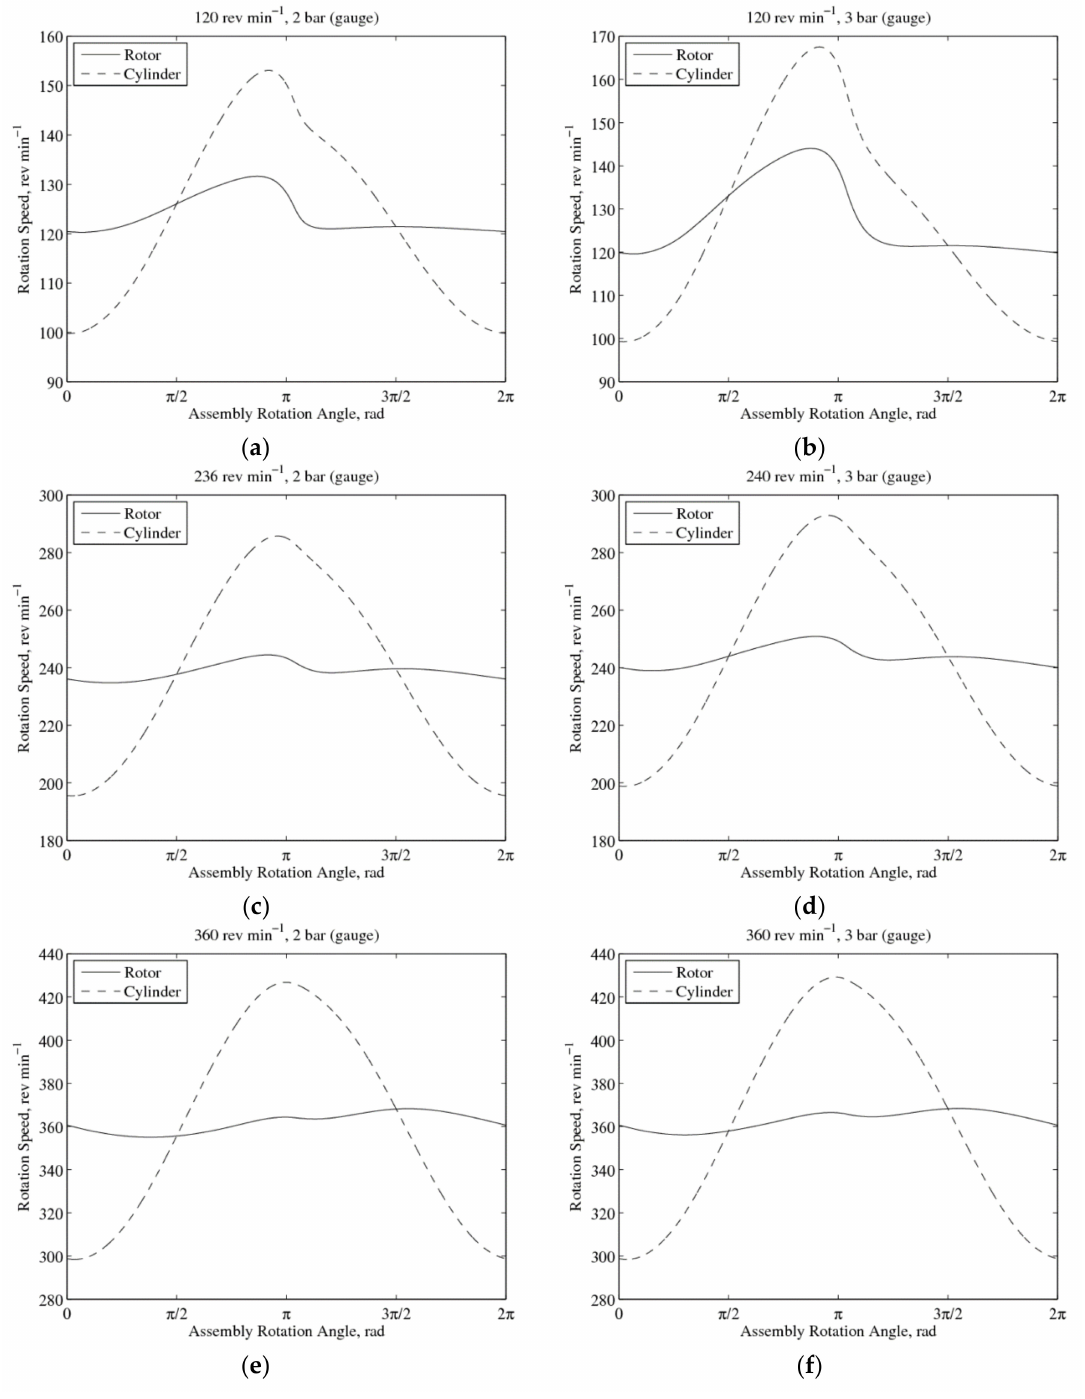
Figure 8. Variation in rotation speeds: ( a ) 120 rev min − 1 with 2 bar (gauge) inlet pressure; ( b ) 120 rev min − 1 with 3 bar (gauge) inlet pressure; ( c ) 236 rev min − 1 with 2 bar (gauge) inlet pressure; ( d ) 240 rev min − 1 with 3 bar (gauge) inlet pressure; ( e ) 360 rev min − 1 with 2 bar (gauge) inlet pressure; ( f ) 360 rev min − 1 with 3 bar (gauge) inlet